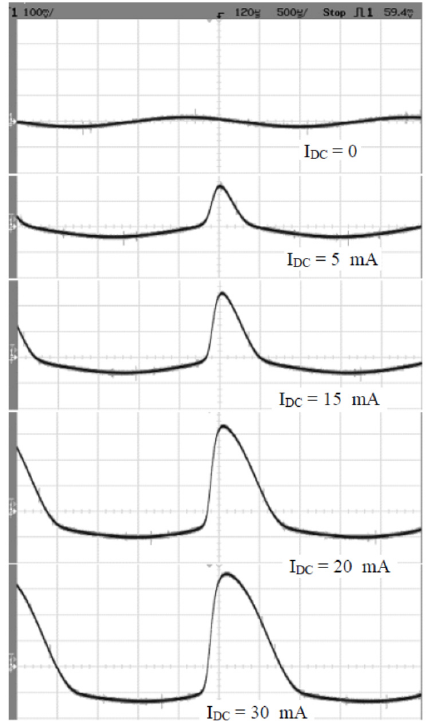
Figure 3. The I exc for several values of I DC ; the vertical scale is 1 A/div. Measured on